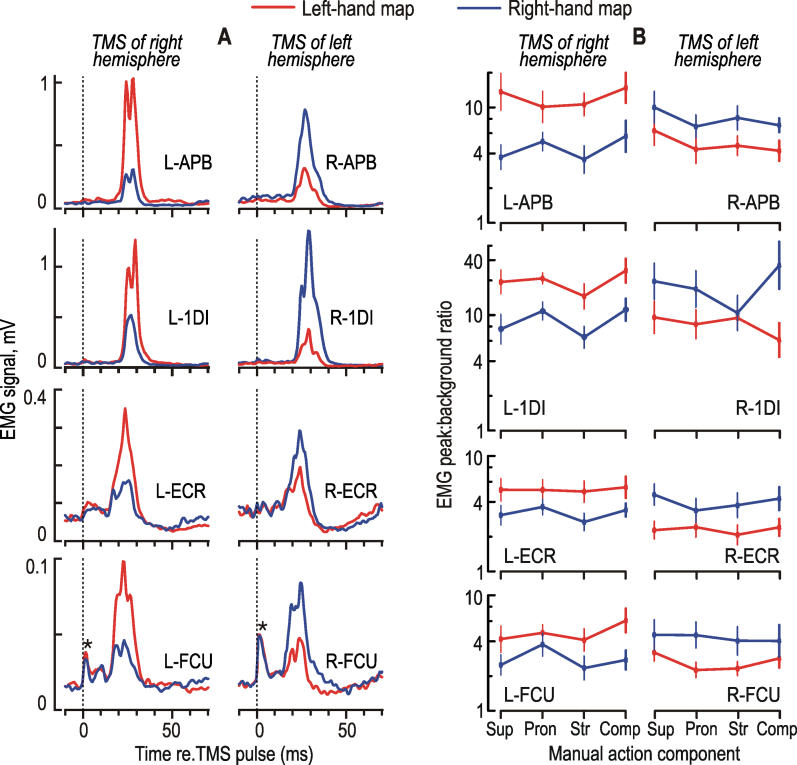
Effects of Mapping Rule on Excitability of Corticospinal Systems Originating in Each Hemisphere Assessed by TMS(A) Short latency EMG responses in intrinsic (APB, 1DI) and extrinsic (ECR, FCU) muscles of the left (L) and right (R) hand evoked by TMS delivered to the contralateral hemisphere in trials with primarily compression forces applied longitudinally to the tool. Data averaged across all participants referenced to time of the TMS pulse (dashed vertical line). Asterisks indicate stimulus artifacts.(B) Ratio between peak amplitude of evoked EMG responses and the corresponding background EMG activity measured in non-stimulated trials plotted against manual action component for all eight muscles. For further details, see
Figure 3C.